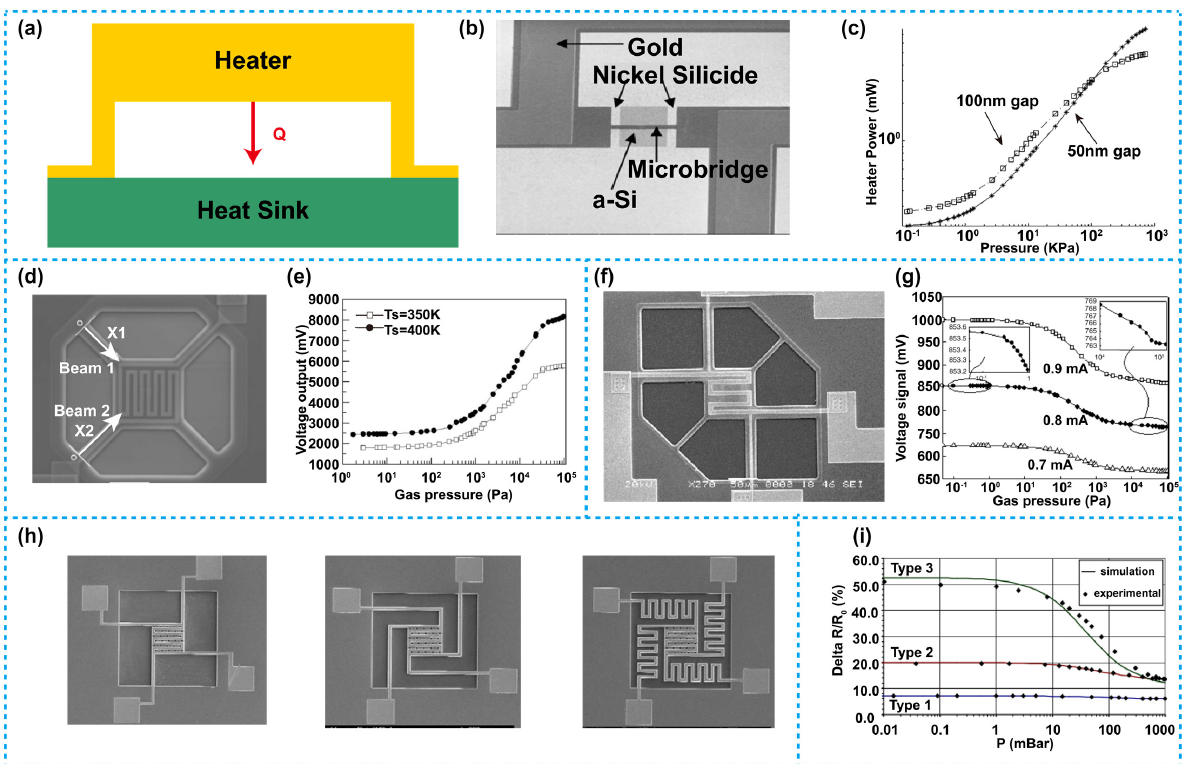
Figure 2. Thermistor-based Pirani sensors with a vertical heat transfer configuration. ( a ) Schematic diagram of such a Pirani sensor. ( b ) A sensor using a NiCr microbridge, such a device has an extremely narrow gap between its heater and the heat sink [66]. ( c ) Heater power variation versus pressure for the sensor in ( b ), the device with a smaller gap between its heater and the heat sink has a larger sensitive range and higher sensitivity. ( d ) A Pirani sensor based on a dielectric membrane structure with four supporting beams [73]. ( e ) The output voltage versus pressure of the sensor in ( d ), its sensitive range was 10 to 10 5 Pa. ( f ) A Pirani sensor based on a dielectric membrane structure with six supporting beams [74]. ( g ) The output voltage versus pressure of the sensor in ( f ), its sensitive range was 10 − 1 to 10 5 Pa. ( h ) A dielectric membrane-based Pirani sensor with three different heater areas [72]. ( i ) The resistance variation versus pressure of the sensors in ( h ), the device with a larger heater area has higher sensitivity and a wider sensitive range than that with a smaller heater area.